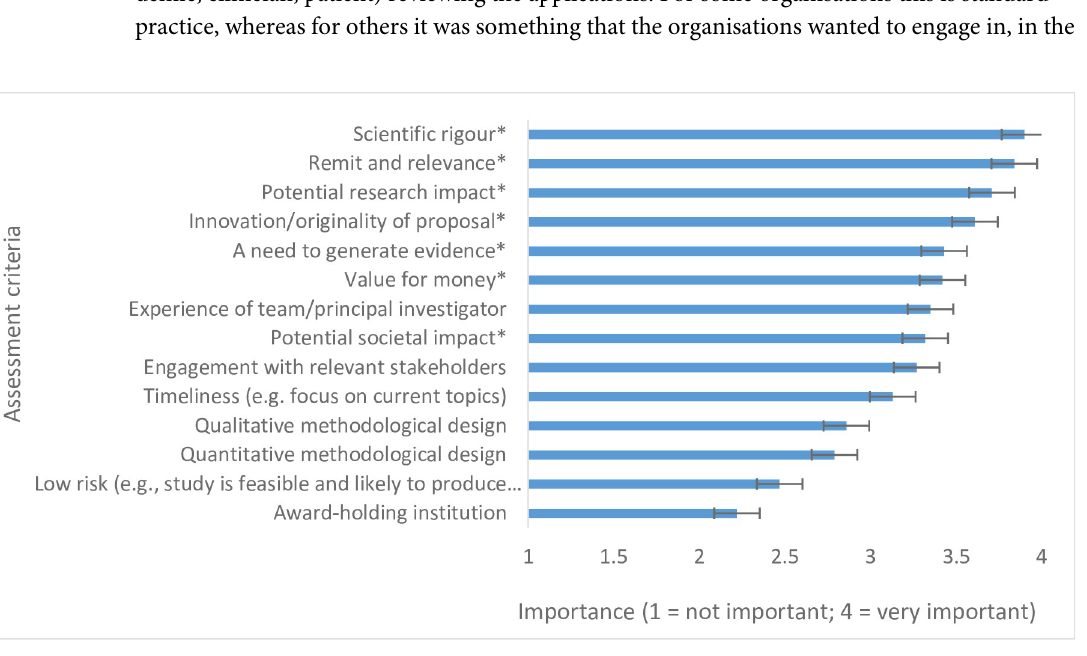
Fig 3. Assessment criteria based on mean scores for importance. 1 = not important and 4 = very important; � denotes those criteria that averaged a median score of 4; Total number of survey responses = 31.